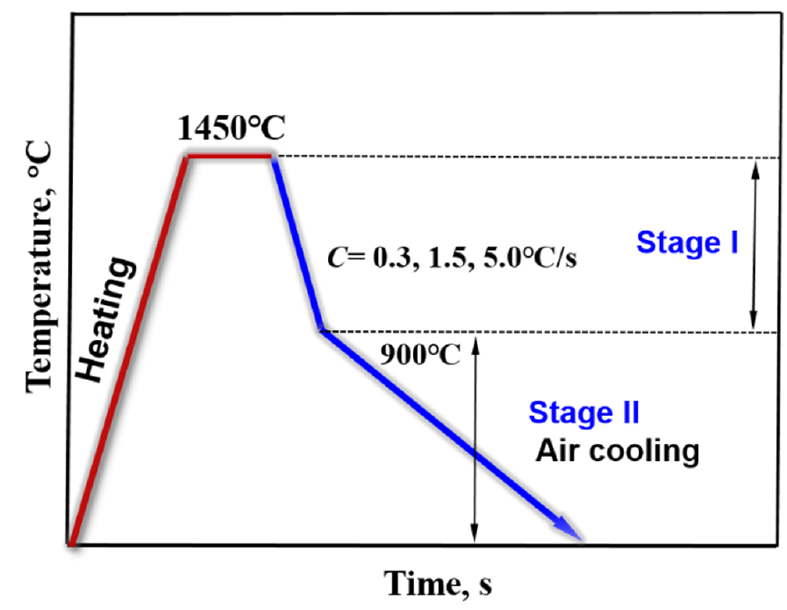
Figure 1. The temperature regime in the CLSM experiment.